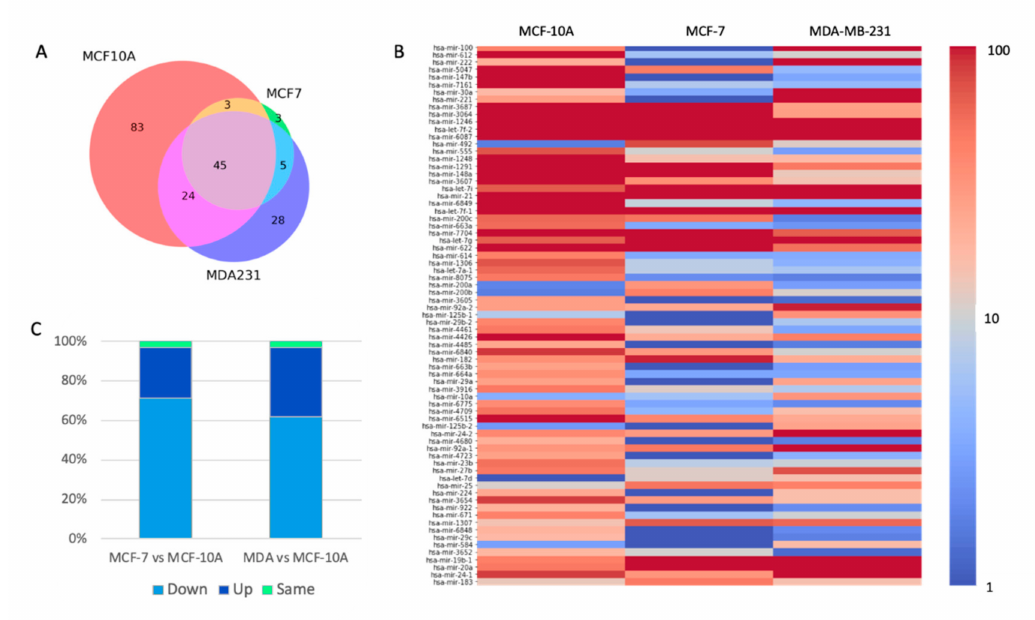
Figure 3. Changes in expression of SF-miRNAs among breast-origin cell-lines. ( A ) Venn diagram showing the partition of di ff erent SF-miRNAs among three breast cancer cell-lines. Source data from Supplementary Table S2. ( B ) Following normalization of reads and testing statistics for di ff erential expression across the three cell-lines, a significant list of 73 SF-miRNAs is shown, colored by the amounts of normalized reads (log 10 scale). All listed SF-miRNAs met the statistical adjusted p -value of < 0.05 and are ranked by their statistical significance. ( C ) Partition of the 73 SF-miRNA according to the 3 possible expression trends composed of up (U), down (D), and S (same). Paired expression trend is the trend for MCF-7 versus MCF-10A and for MDA-MB-231 versus MCF-10A. The dominant observed trend is marked as D, followed by U. MDA-MB-231 marked as MDA, or MDA231. The data source is in Supplemental Table